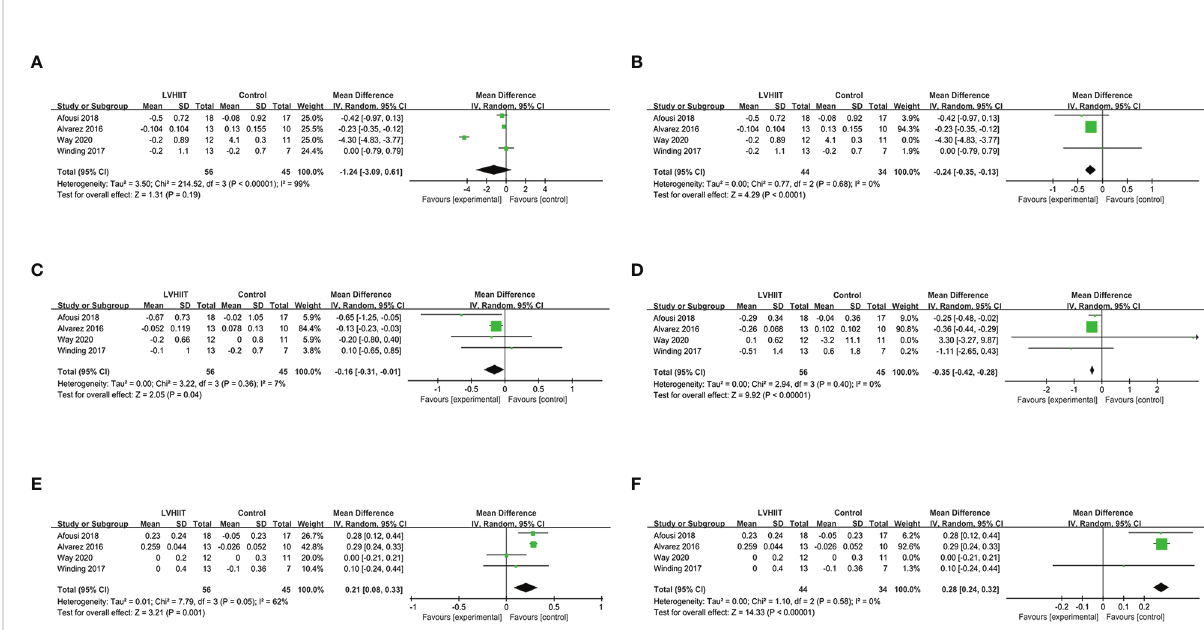
FIGURE 7 Forest plot for the meta-analysis of lipid pro fi le (A) total cholesterol and (B) after sensitivity analysis; (C) low density lipoprotein; (D) triglyceride; (E) high density lipoprotein and (F) after sensitivity analysis.